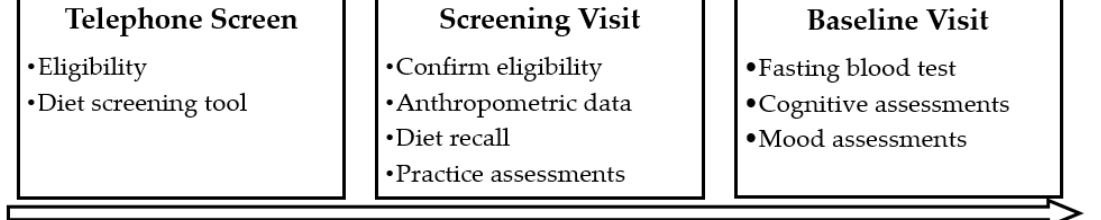
Figure 2. Schedule of Assessments.